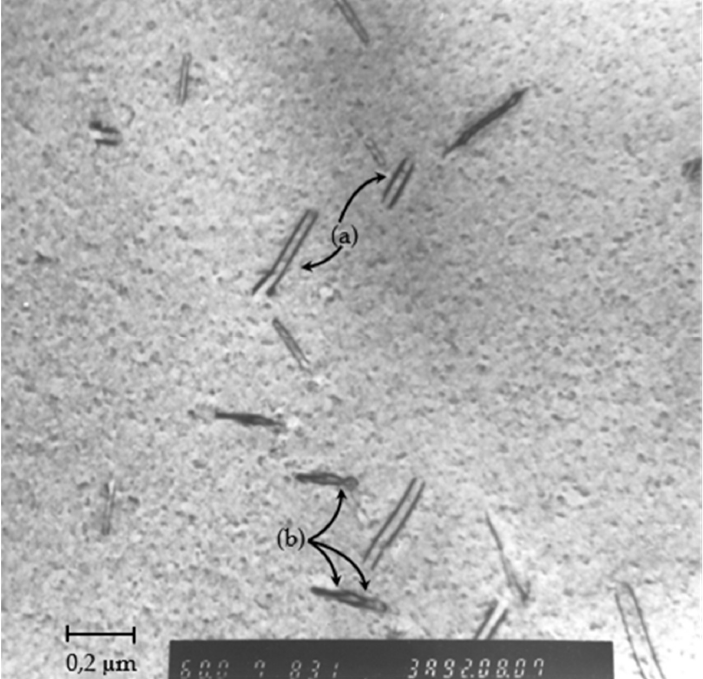
Figure 2. Pairs of dislocations, the pairing of dislocations is the result of the presence of coherent PMI. Legends: ( a ) two relaxed dislocation pairs (in the Nb solid-solution), ( b ) the arrows point towards the pinched regions of dislocation pairs, corresponding to strongly coupled segments of the dislocations.